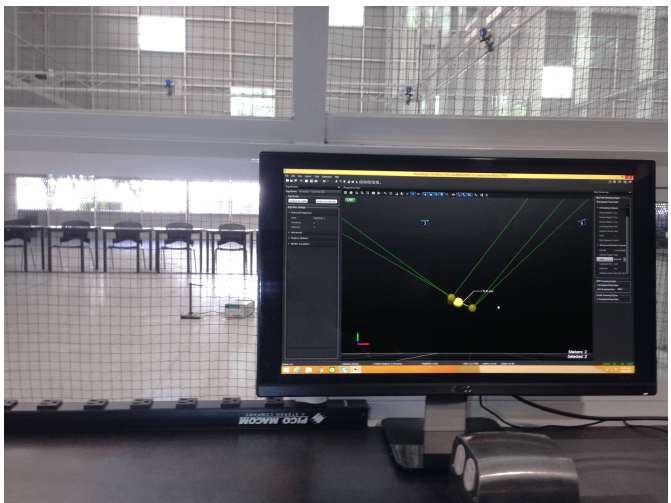
Figure A1. The setup of the motion capture system.